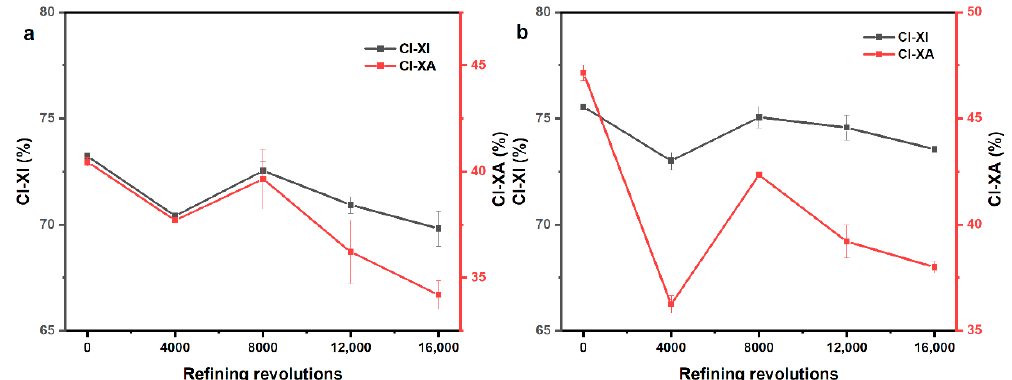
Figure 4. The CI-XI (crystallinity index obtained by comparing intensity of X-ray diffractometer (XRD) peaks) and CI-XA (crystallinity index obtained by comparing area of XRD peaks) for refined and unrefined samples: ( a ) softwood fiber and ( b ) hardwood fiber. Table 1. ( a ) The CI of softwood fibers through refining. ( b ) The CI of hardwood fibers through